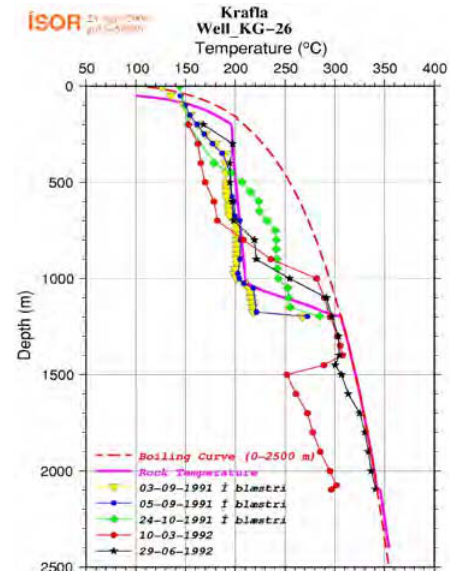
Figure 4. Pressure curves corresponding to the temperature logs in well KG-26. The initial pressure curve corresponds to the initial pressure within the